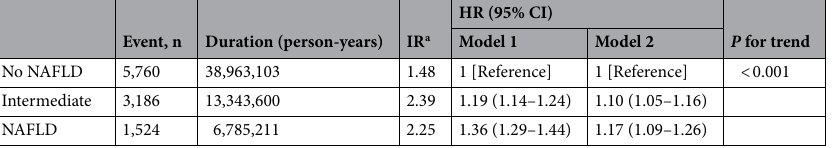
Table 2. Association between non-alcoholic fatty liver disease and the risk of pancreatic cancer. Fatty liver index: ≥ 60, NAFLD; 30–59, intermediate; < 30, no NAFLD. Model 1 was adjusted for age and sex. Model 2 was adjusted for age, sex, smoking status, alcohol consumption, physical activity, income, diabetes, pancreatitis, and body mass index. CI confidential interval, HR hazard ratio, NAFLD non-alcoholic fatty liver disease. a IR, the incidence rate per 10,000